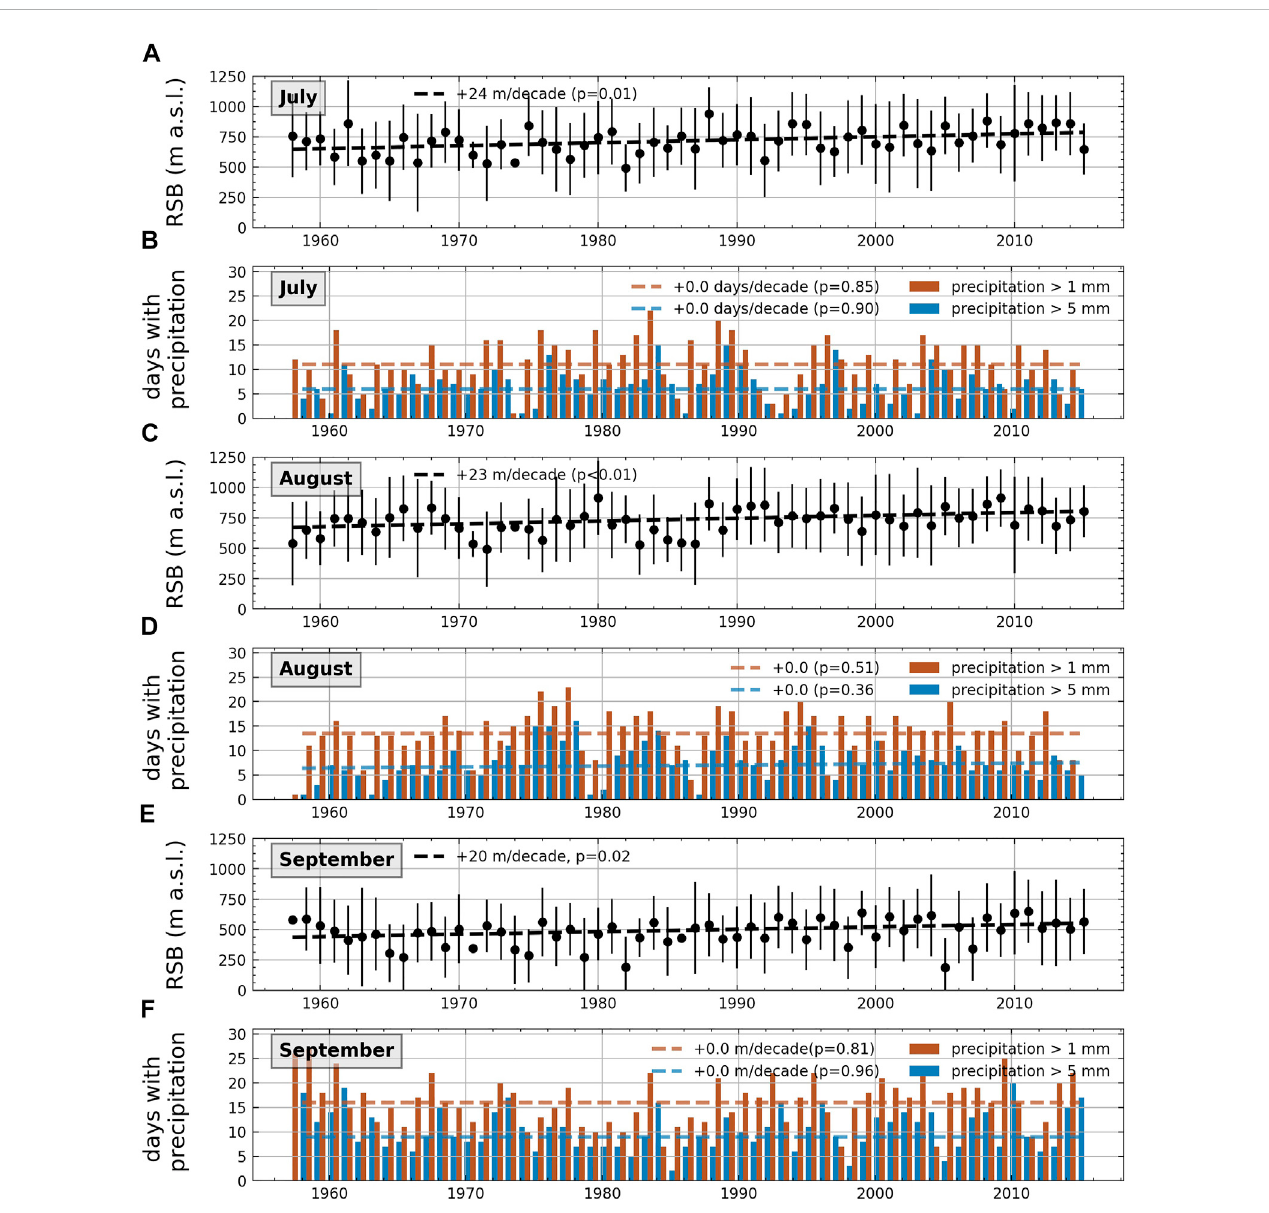
FIGURE 6 Estimated RSB from RACMO2-1.0 km model data for GIC on Ammassalik island. The monthly averages for July (A) , August (C) and September (E) are plotted as black dots and standard deviation is plotted as the vertical black bar. The number of days with precipitation above the threshold of > 1 mm (brown) and > 5 mm (blue) are highlighted for June (B) , July (D) and August (F) . For both the RSB and days with precipitation linear trends are indicated with a dashed